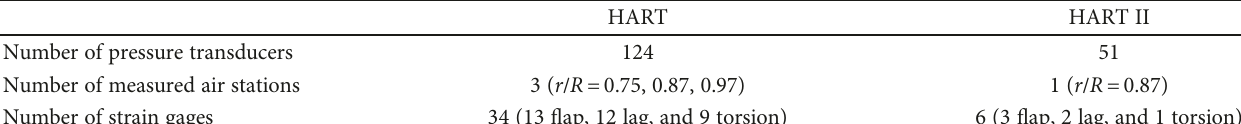
Table 1: Comparison of instrumentations for airloads and structural loads.